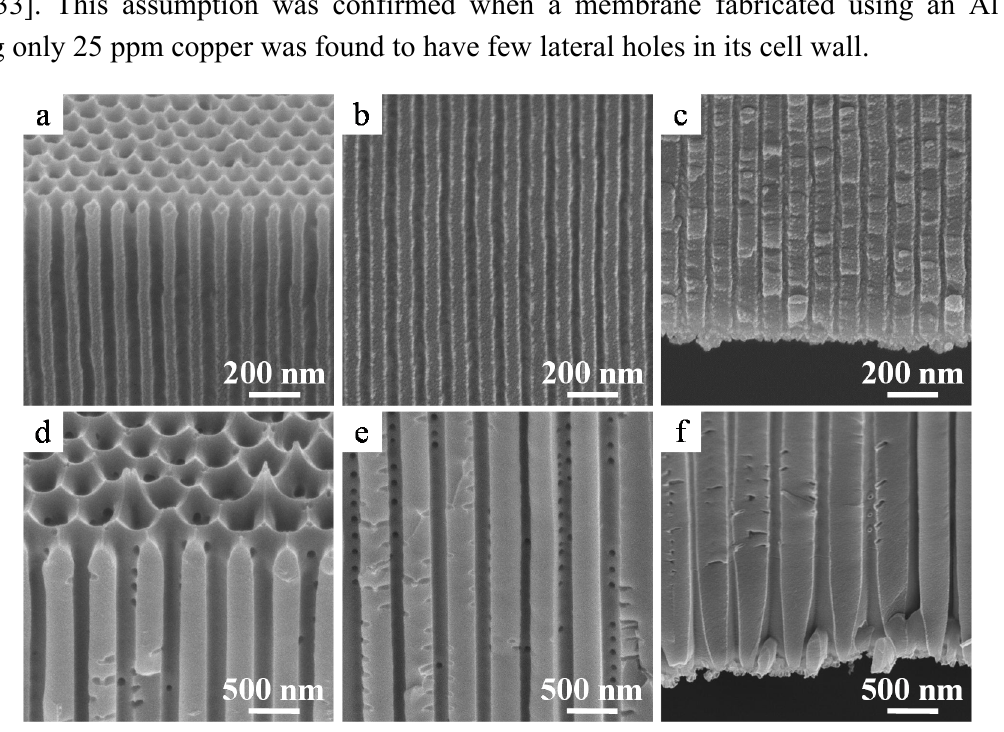
Figure 2. Cross-sectional scanning electron microscopy (SEM) images of the as-detached amorphous alumina membranes formed in ( a – c ) oxalic acid at 40 V and ( d – f ) phosphoric acid at 185 V. ( a , d ) Top, ( b , e ) middle, and ( c , f ) bottom portions of the alumina